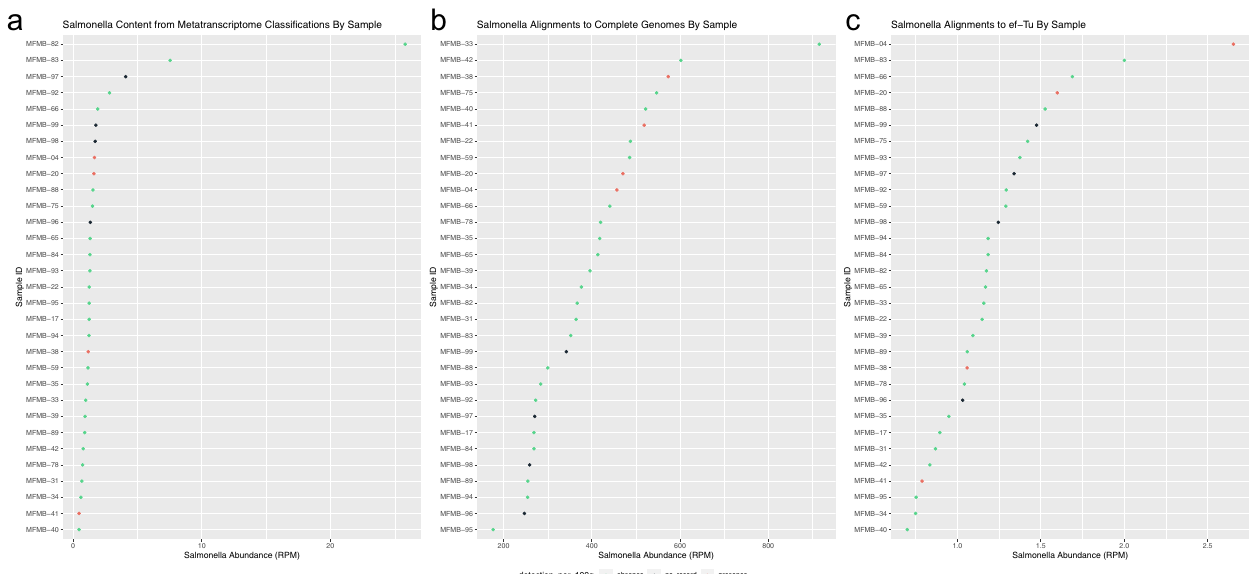
Fig. 7 Salmonella culture-positive status vs. high-throughput sequencing read abundance. Read abundance (RPM) shown from a k -mer classi fi cation to NCBI Microbial RefSeq Complete, b alignments to 1447 Salmonella genomes, and c alignments to 4846 EF-Tu gene sequences. Salmonella presence (red) indicates culture-positive result, absence (green) indicates culture-negative result, and no record (black) indicates samples for which no culture test was completed.